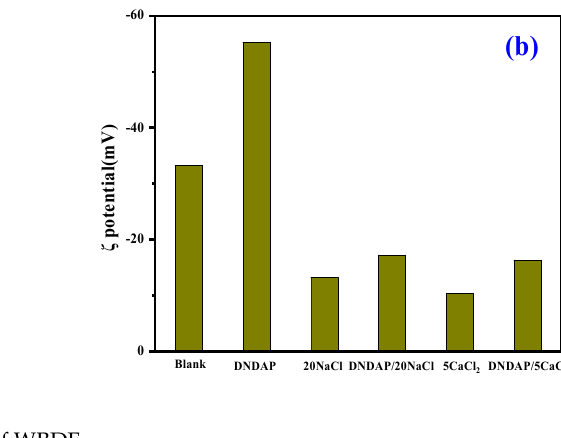
Figure 10. Zeta potential value of WBDF.